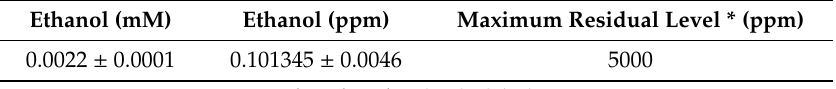
Table 7. Concentration of residual organic solvent in the optimized formulation.